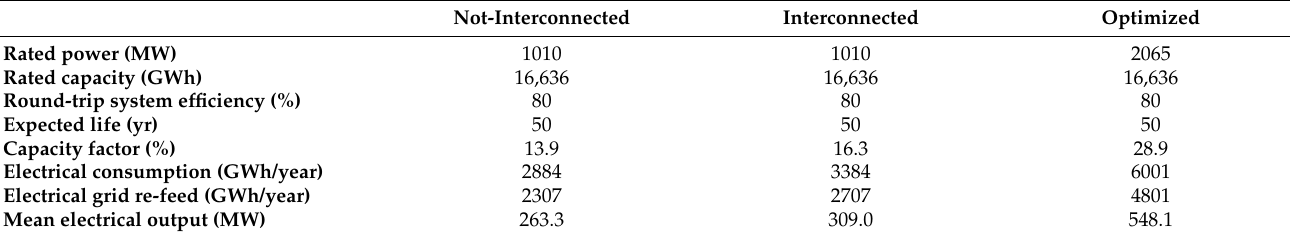
Table 13. Reverse pumping storage system summary.